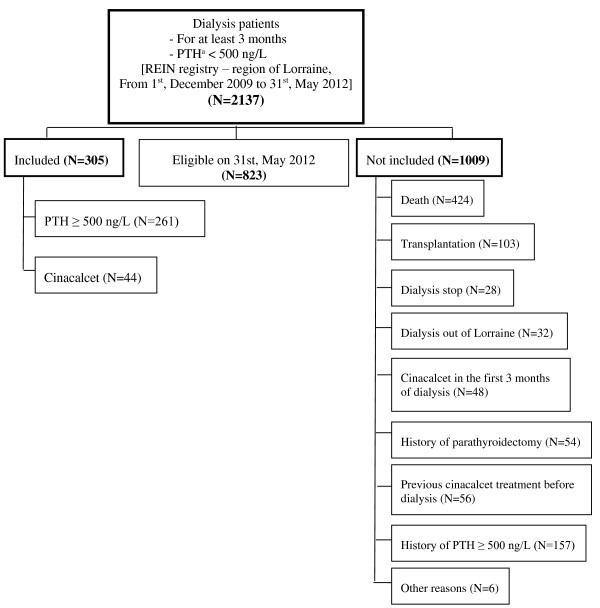
Disposition of patients. aParathyroid hormone.